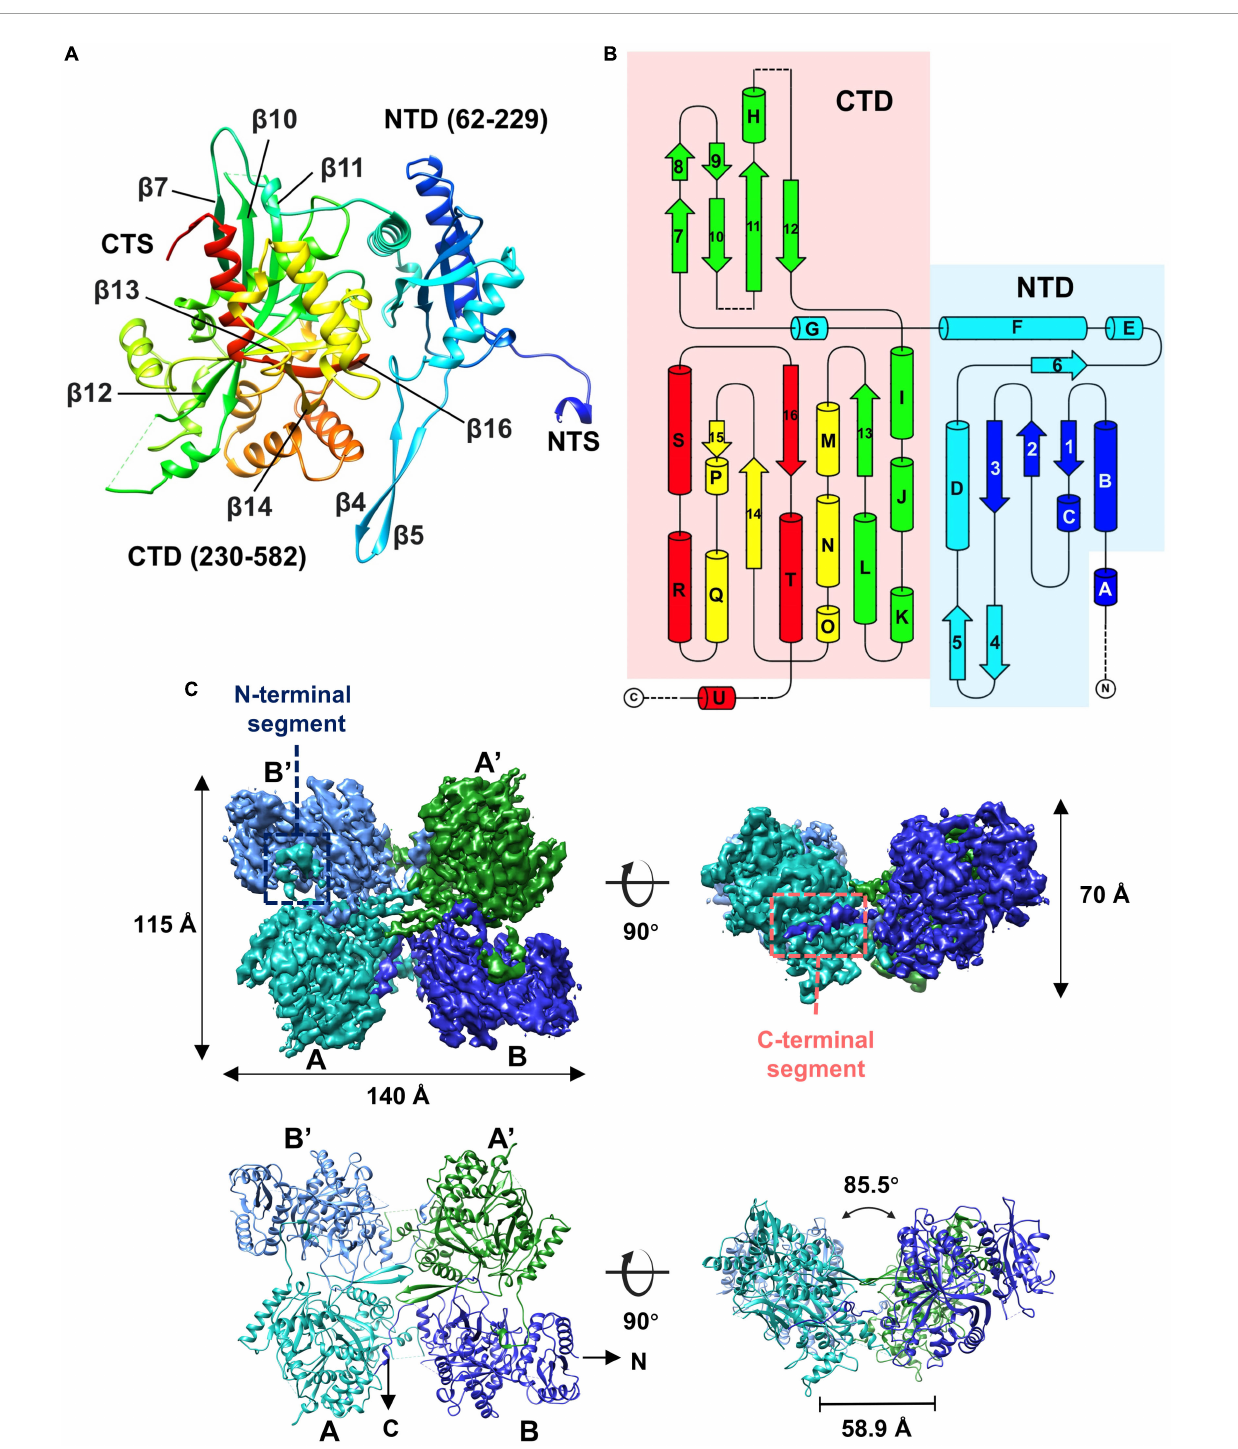
FIGURE4 Overall structure of the gp105 concave tetramer. (A) Ribbon diagrams showing the structure of a gp105 monomer (molecule A) in the concave tetramer. The structure is colored as a rainbow from the N terminus (blue) to the C terminus (red). The N-terminal domain is colored from blue to cyan and the C-terminal domain is colored from green to red. The dashed lines represent unresolved loops. (B) Diagrams showing the topology of gp105. (C) Surface rendered representations and ribbon diagrams showing the overall structure of the concave tetramer. Left-top is the top view of the gp105 concave tetramer assembly, and the right-top is the front view of the gp105 concave tetramer. The structure is shown as a ribbon diagram with the N terminus and C terminus labeled. The map is contoured at 4.3 σ . Molecule A is colored cyan, molecule B is colored dark blue, molecule A’ is colored green, and molecule B’ is colored light blue. AB’ and A’B are the symmetry-related